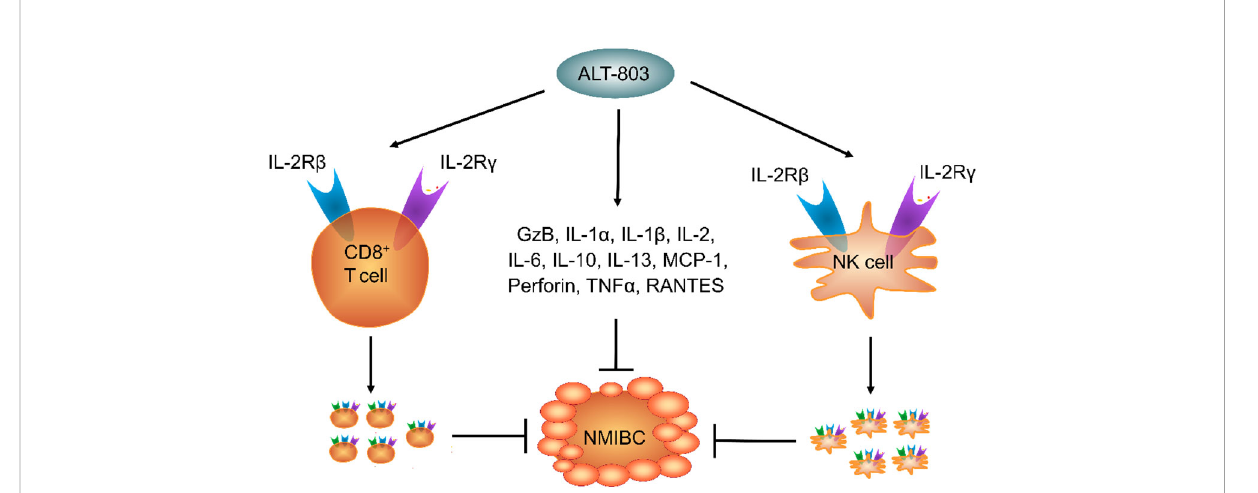
FIGURE 1 The mechanism of ALT-803 for the treatment of non-muscle-invasive bladder